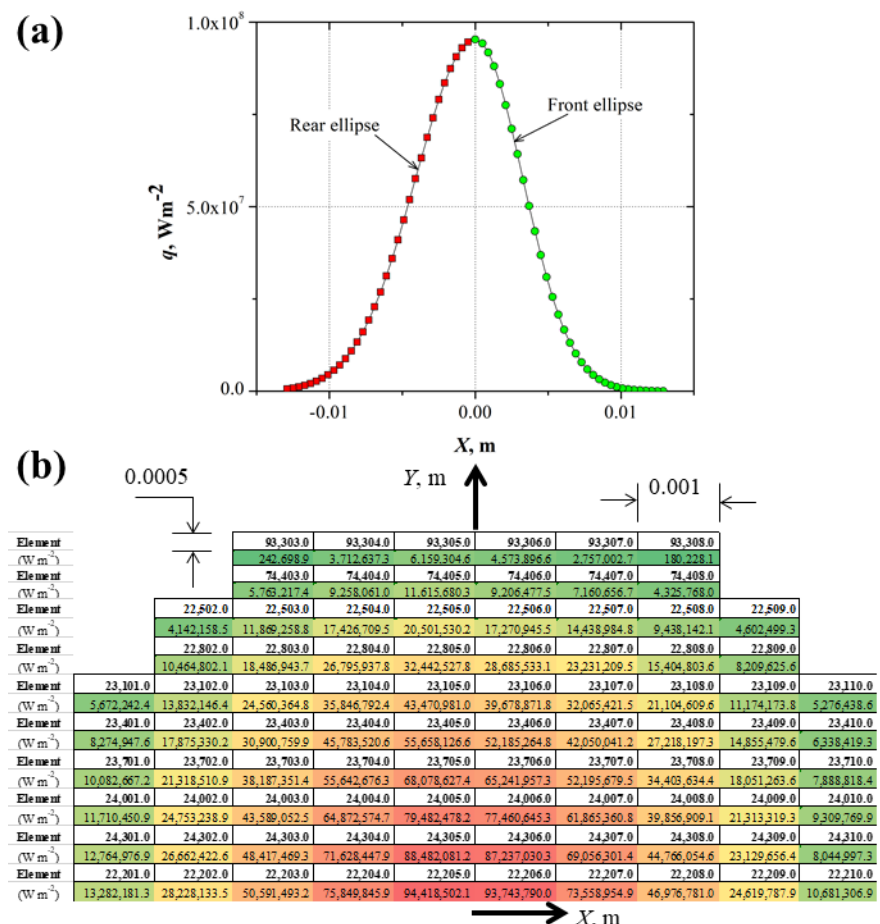
Figure 5. Heat flux distribution according to the double ellipse model: ( a ) heat flux as a function of distance and ( b ) heat flux applied to each finite element.